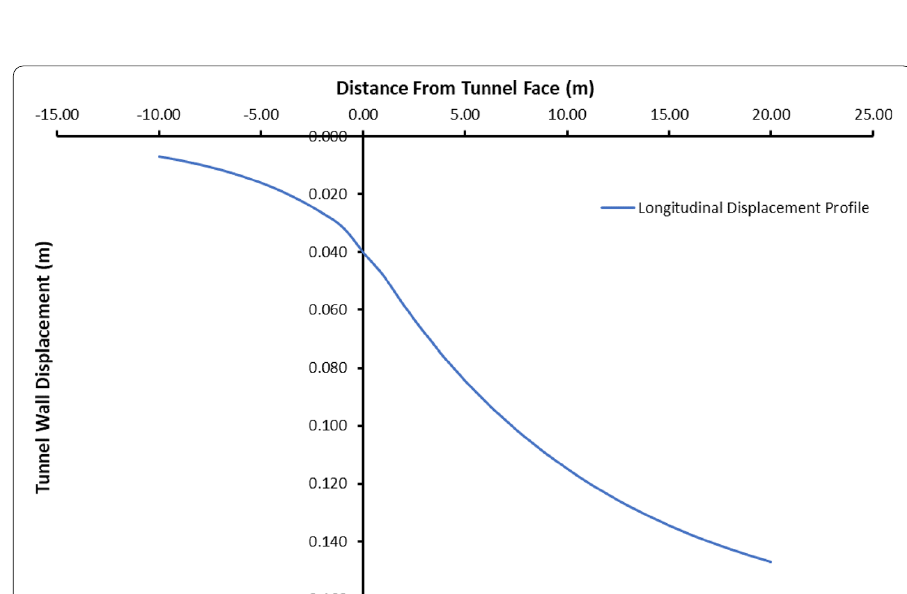
Fig. 11 LDP between the inlet portal and km: 210 and Diederichs